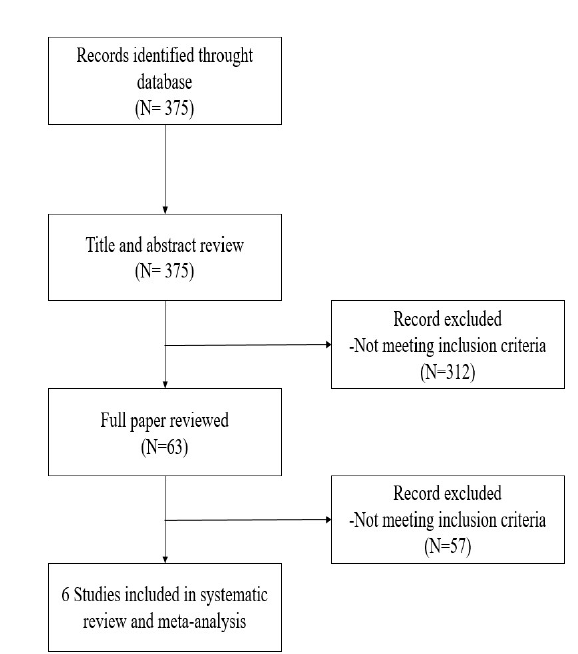
Figure 1. PRISMA flow diagram showing literature search results. Six trials were included in the analysis. Table 1. Trial characteristics.